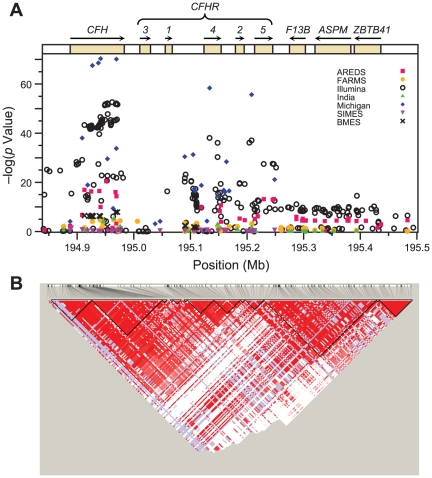
The strength of the association signal, as indicated by −log(p value) on the Y-axis, is plotted against SNP location on chromosome 1 on the X-axis.The (A) panel shows the p-values from individual clinical cohorts which are labeled in different colors and shapes (see Labels). The SNPs located within the 32 kb critical region show the best association signal in the 6 clinical datasets. Panel (B) shows the distribution of pair-wise linkage disequilibrium (D′) values between CFH and ZBTB41. The LD blocks are marked with black triangles; red indicates D′ values of 1 (complete LD) while white indicates D′ values of 0 (no LD whatsoever).